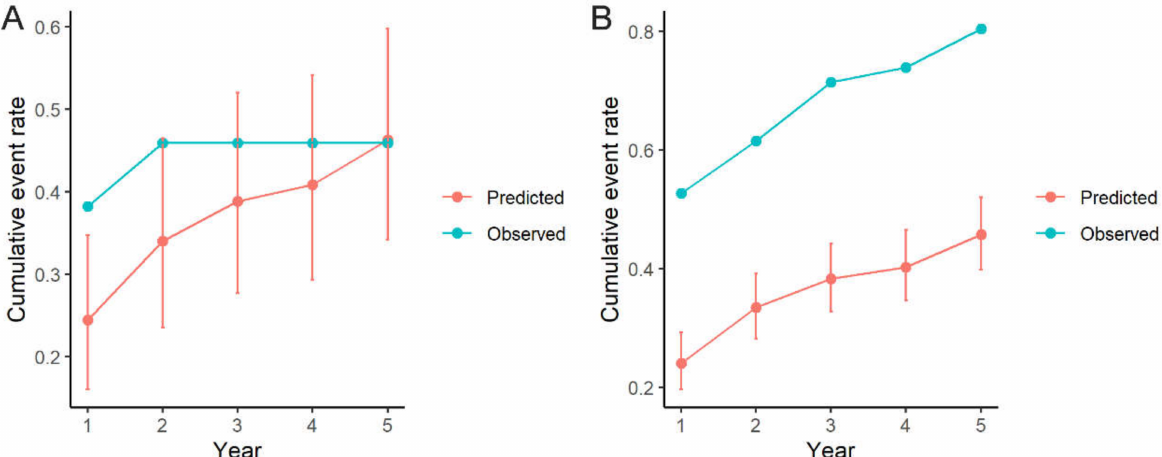
Figure 3. Comparison between model-predicted and observed event rates in patients implanted with ICDs for ( A ) primary prevention of SCD; ( B ) secondary prevention of SCD. ICD, implantable cardioverter-defibrillator. SCD, sudden cardiac